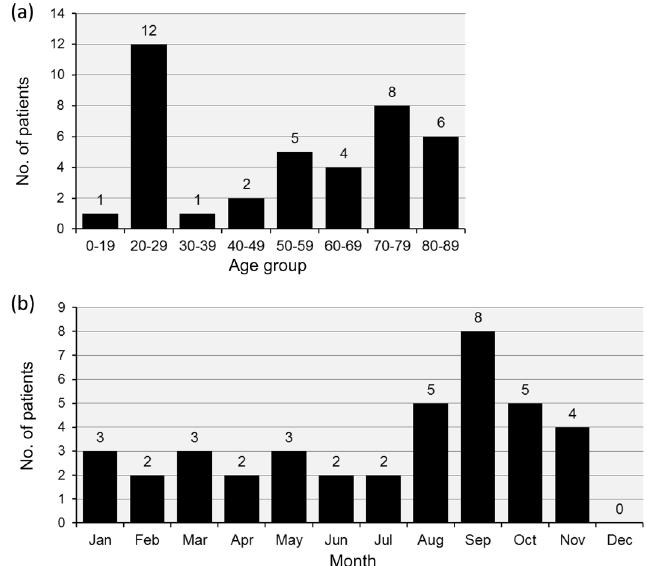
Figure 1. Incidence of Campylobacter bacteremia by age group and month. Patient age groups were distributed bimodally between the 20s and the elderly ( a ). An incidence peak was observed in September ( b ).